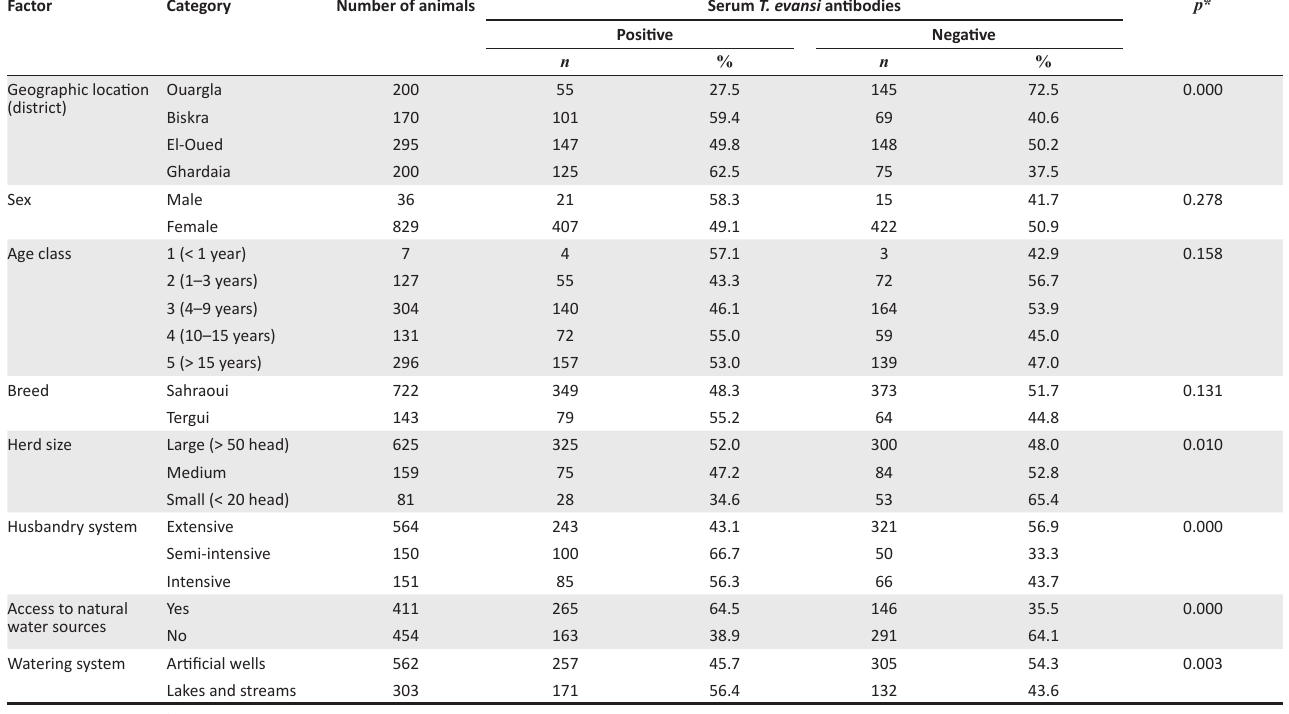
TABLE 1: Factors associated with animal-level seroprevalence of antibodies against Trypanosoma evansi for dromedary camel populations of southeastern Algeria. Factor Category Number of